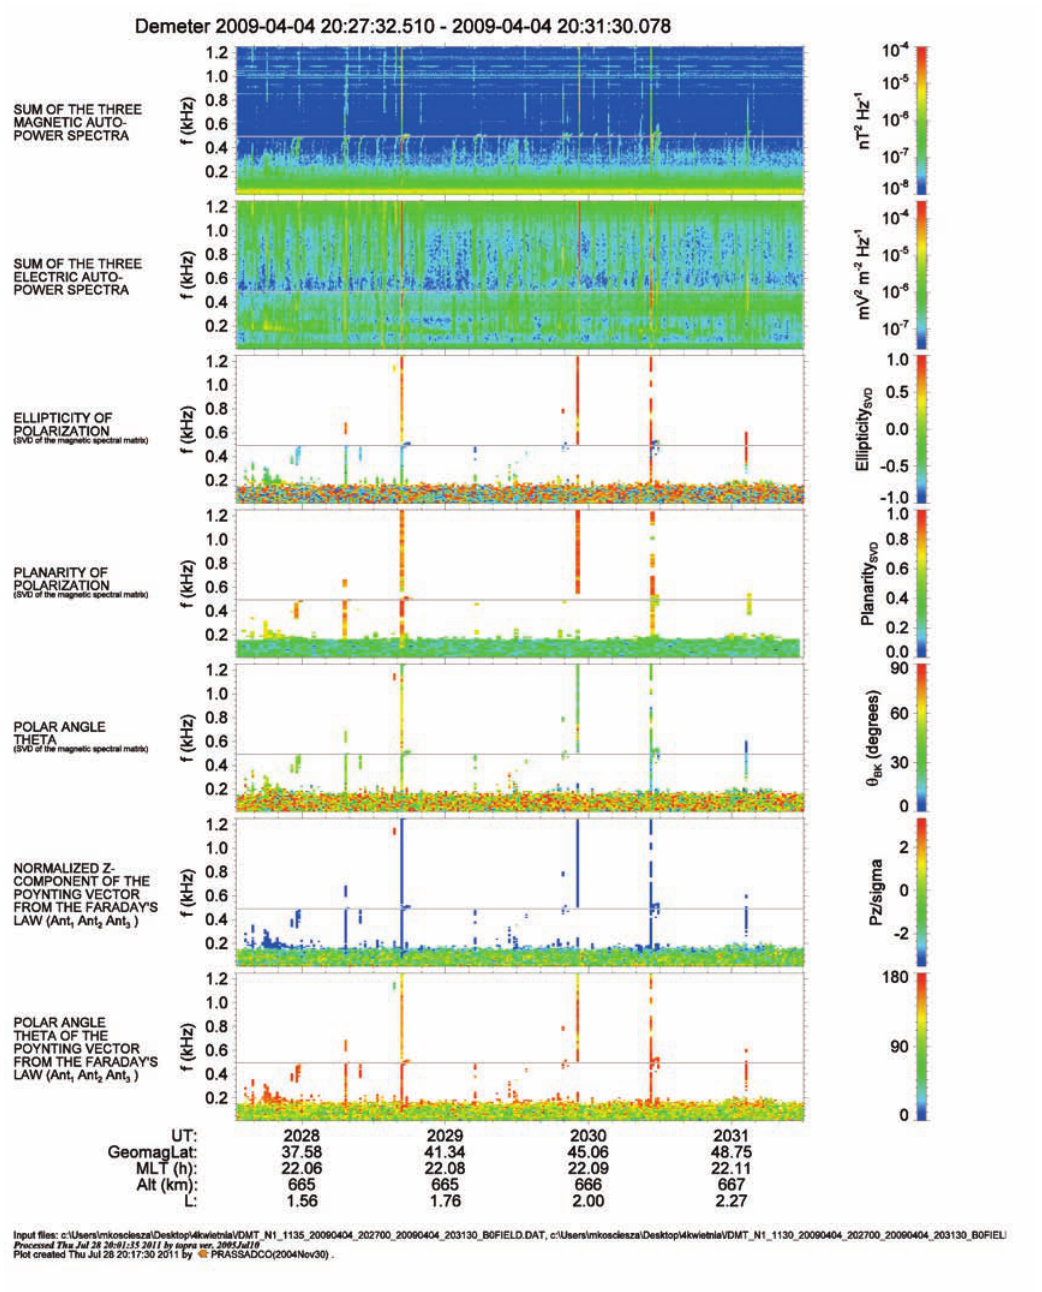
Figure 8. Detailed propagation analysis of a part of the ELF signal registered on April 4, 2009, as a function of time. Top to bottom: the two first panels show the spectrum of the magnetic and electric field variations (sum of the 3 components), the third panel shows the ellipticity of the magnetic field polarization. A value of 1 means right-hand circularly polarized waves; linear polarization gives 0; and −1 indicates left-hand circular polarization. The fourth panel is the sense of the polarisation of the waves, and the fifth panel indicates the angle between the Poynting vector and the Earth magnetic field, as calculated by the singular value decomposition technique [Santolík et al. 2003]. The bottom panel shows the z-component of the Poynting vector. Empty areas in the four bottom panels correspond to magnetic power-spectral densities below 10 −7 nT 2 Hz −1 . In each panel, the black line is related to the proton gyrofrequency. The geomagnetic latitude and the magnetic local time (MLT) are displayed at the bottom of the figure according to the Universal Time